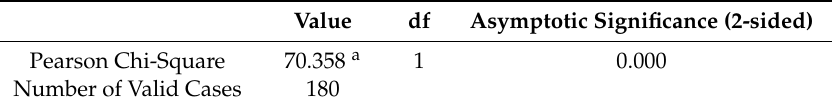
Table 8. Chi-Square test for Willingness to purchase results (N.